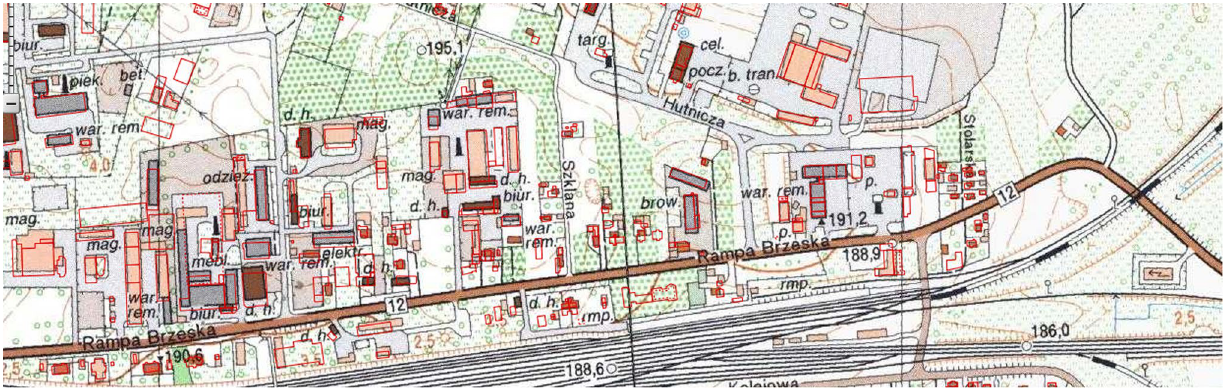
Fig. 1 Spatial development of the studied area (http:// www. umche lm. bip. lubel skie. pl. xxxx)